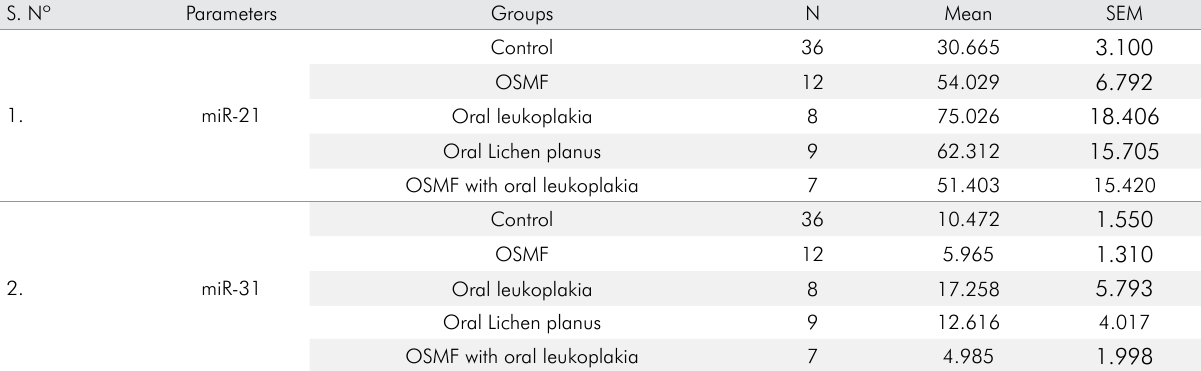
Table 1. Mean (SE) of fold difference of salivary miRNA-21 and miRNA-31 in various. S.